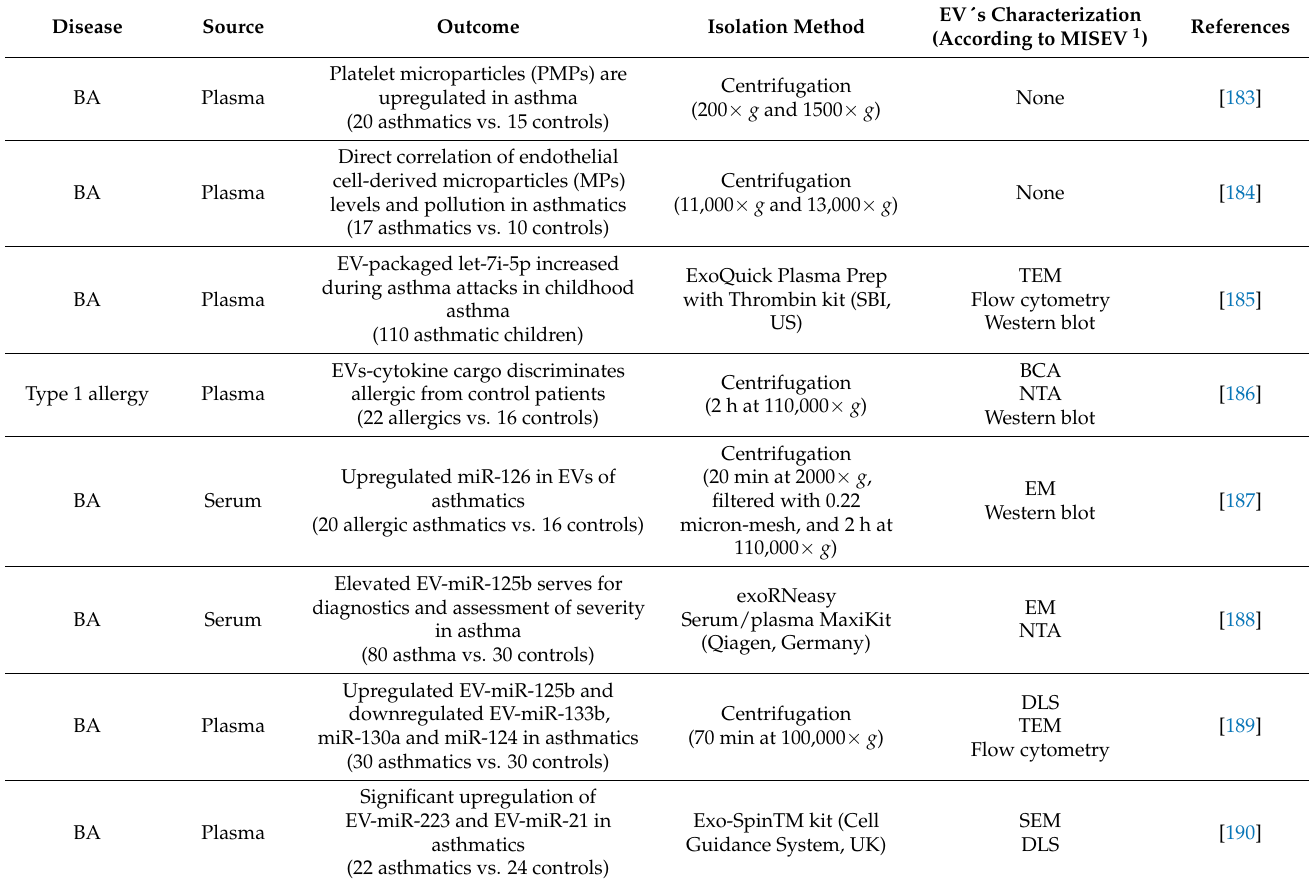
Table 2. Studies exploring the potential as biomarkers of circulating EVs included in this work. TEM: transmission electron microscopy, UC: ultracentrifugation, NTA: nanoparticle tracking analysis, BCA: bicinchoninic acid assay, DLS: dynamic light scattering, SEM: scanning electron microscopy, SEC: size exclusion chromatography, PBMC: peripheral blood mononuclear